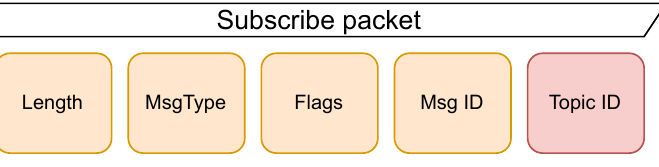
Figure 7. Subscribe packet format.